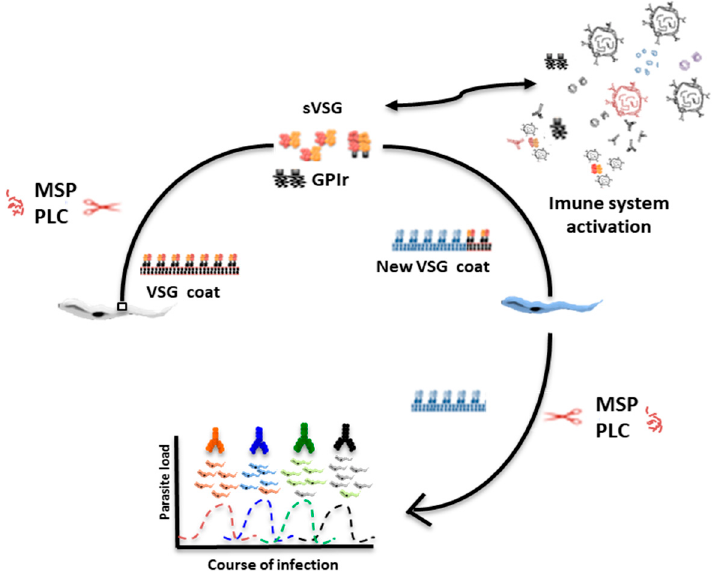
Figure 2. Mechanism of VSG release in Trypanosome brucei . Trypanosomes avoid detection by host antibodies by recurrently switching to new VSG coats through major surface proteases (MSP) and phospholipase-C (PLC) cleavage. MSP and PLC enzymes seem to have a synergistic activity in the efficient release of VSG molecules on the surface of the parasite. The trypanosome surface coat is extremely dense, covered by millions of repeats of developmentally specified proteins. The mechanism of VSG cleavage releases soluble VSG (sVSG) and glycosylphosphatidylinositol (GPI) residues (GPIr). Both, sVSG and GPIr are able to activate and modulate immune system response by removal of preformed circulating antibodies and formation of immune complexes. The transitions in composition of the surface coat that covers the plasma membrane is essential for T. brucei survival in the host.